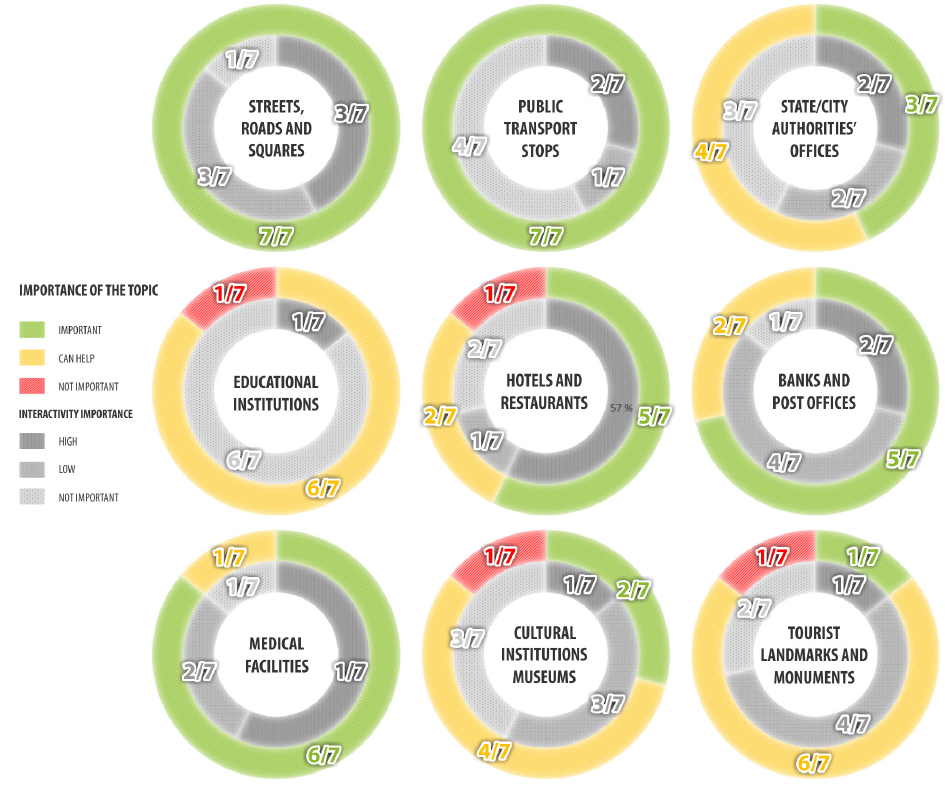
Figure 5. Map content demands according to the preliminary user preferences survey.